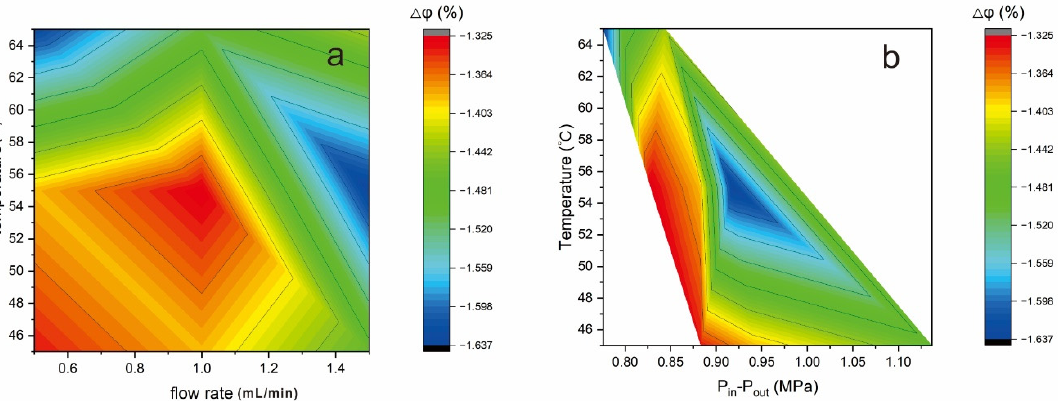
Figure 5. Contour plot of porosity variation under different conditions. ( a ) Porosity variation under different temperature and flow rate conditions; ( b ) Porosity variation under different temperature and differential pressure conditions.